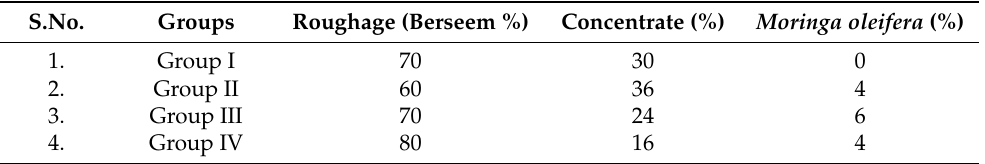
Table 1. Different groups and feed ratios used in the